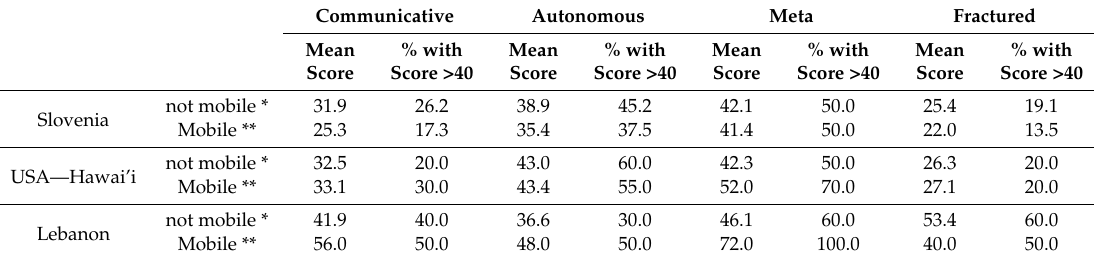
Table 3. Mean scores and percentages with scores exceeding 40 (out of 80) for the four reflexivity types. Communicative Autonomous Meta Fractured Mean % with Mean % with Mean % with Mean % with Score Score >40 Score Score >40 Score Score >40 Score Score >40 not mobile Slovenia